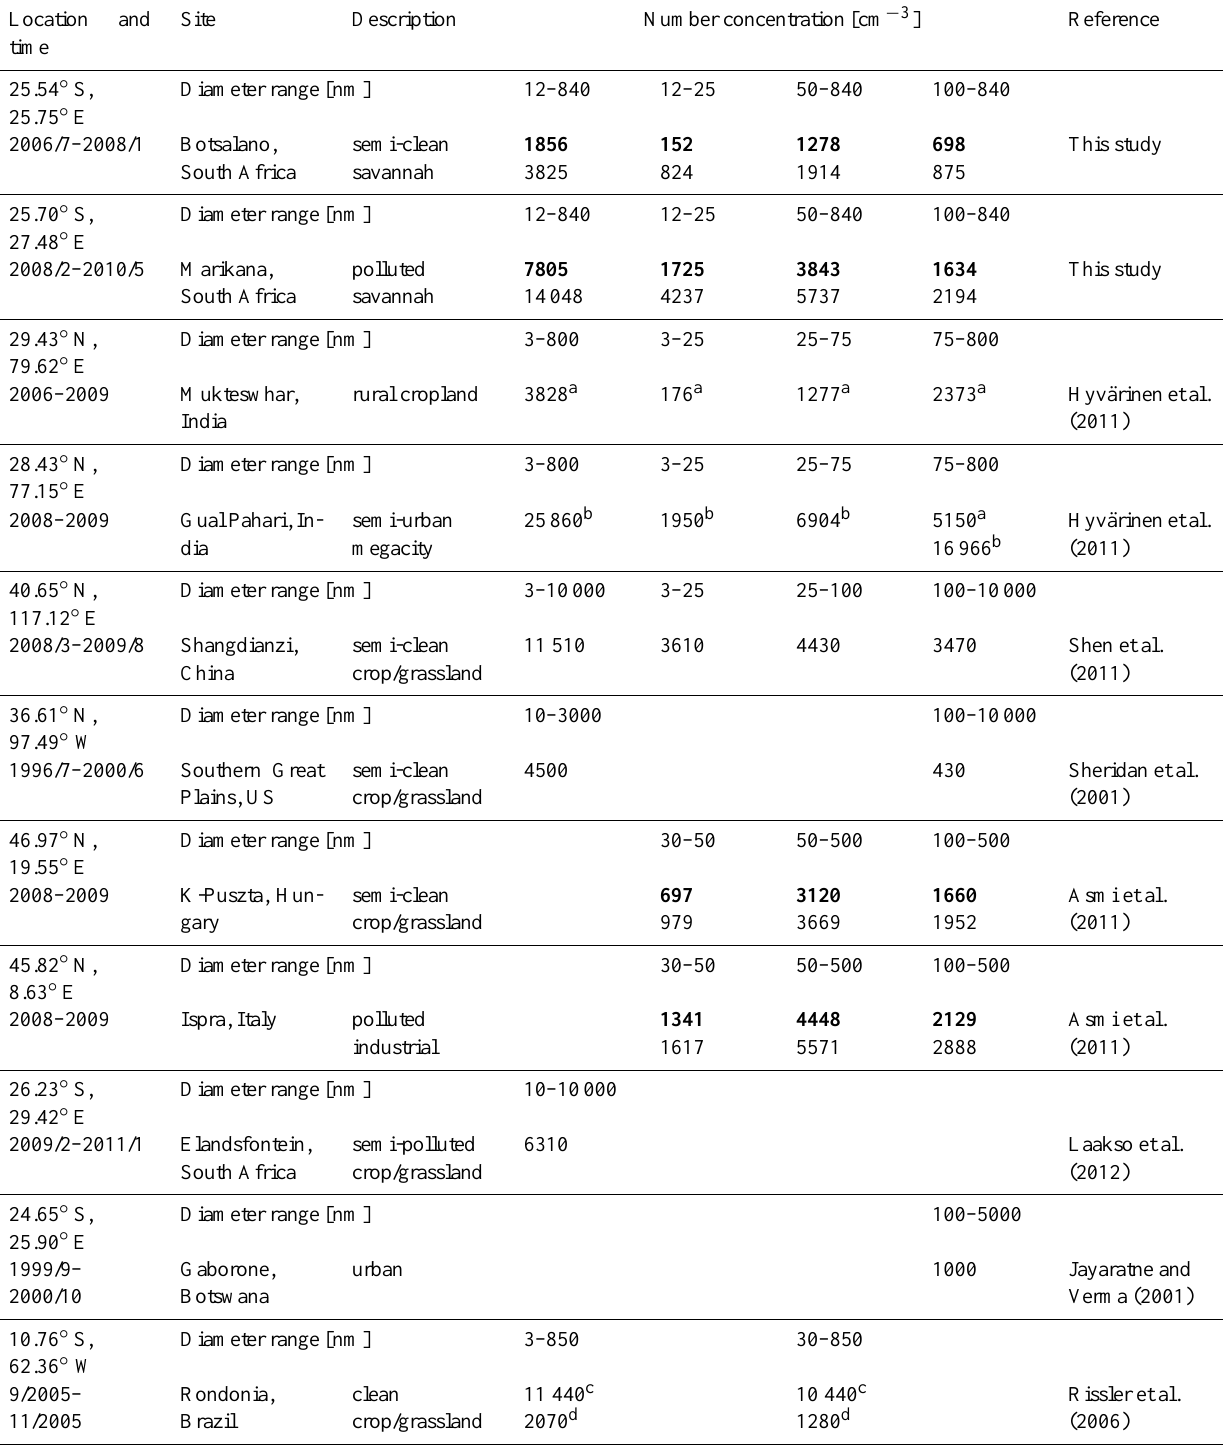
Table 1. Median and mean aerosol number concentrations for Botsalano and Marikana on different size ranges. Medians are indicated with bold font. Number concentrations, locations an short descriptions of the selected comparison measurements are also included.